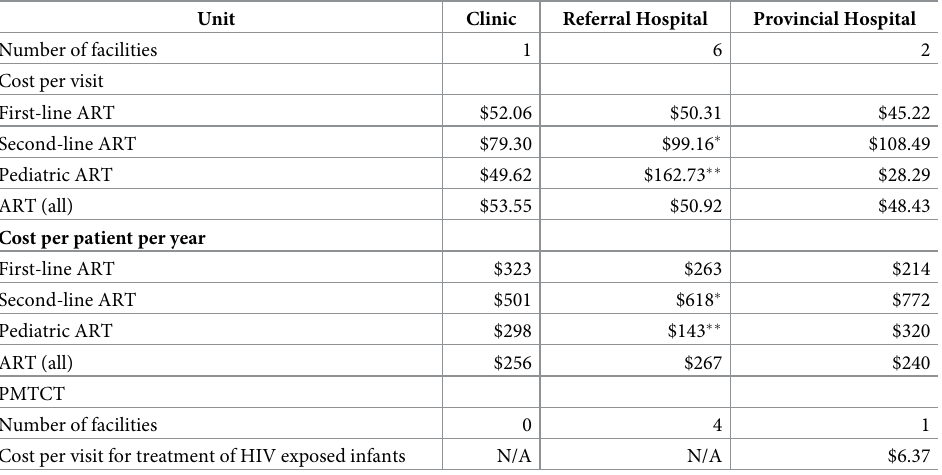
Table 6. Unit costs of ART